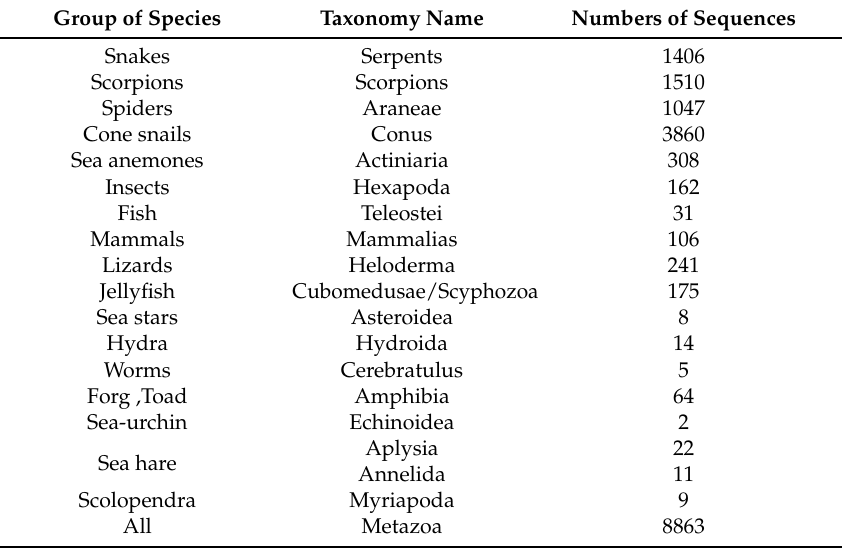
Table 1. Summary of sequence numbers in our achieved Toxin Database. Group of Species Taxonomy